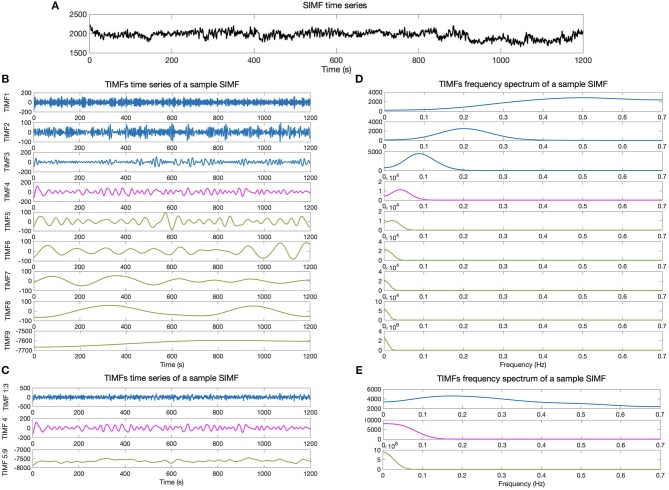
Temporal IMFs and their corresponding frequency spectrum of the sample SIMF time series. (A) Sample of SIMF time series before temporal decomposition (B) 9 decomposed TIMFs of a sample SIMF by applying the ICEEMDAN method with 300 ensembles and a level of noise of 0.2. (C) The 9 decomposed TIMFs are divided into three different frequency bands. According to slow1 to slow3 and slow5 frequency bands defined in the literature, TIMFs1 to 3 and 5 to 9 are combined, respectively. (D) Represents the frequency spectrum of the 9 TIMFs. (E) The frequency spectrum of TIMFs in part (C) that correspond to frequency bands used in the literature for slow1 to slow5 Penttonen and Buzsáki (2003), Zhan et al. (2014). TIMF, Temporal Intrinsic Mode Function; ICEEMDAN, Improved Complete Ensemble Empirical Mode Decomposition with Adaptive Noise.